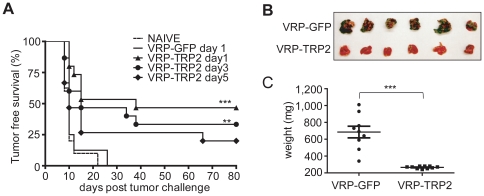
VRP-TRP2 has a potent anti-tumor effect in a therapeutic setting.(A) Kaplan-Meier tumor-free survival curves are shown for 10/15 mice per group. Mice received i.d. injections of VRP expressing the indicated MDAs either 1or 3 days after challenge with B16 melanoma (therapeutic setting). As a negative control, groups of mice were injected with VRP-GFP or left untreated (NAÏVE). (B) Representative photograph and (C) weight of lungs resected 24 days after tumor inoculation from mice treated with VRP-GFP or VRP-TRP2 (lung therapeutic model). Each dot represents an individual mouse. *** P<0.0001, ** P<0.001.